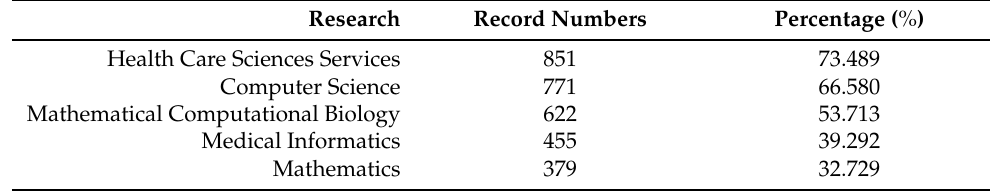
Table 1. Statistics of research papers on artificial intelligence in the field of medical